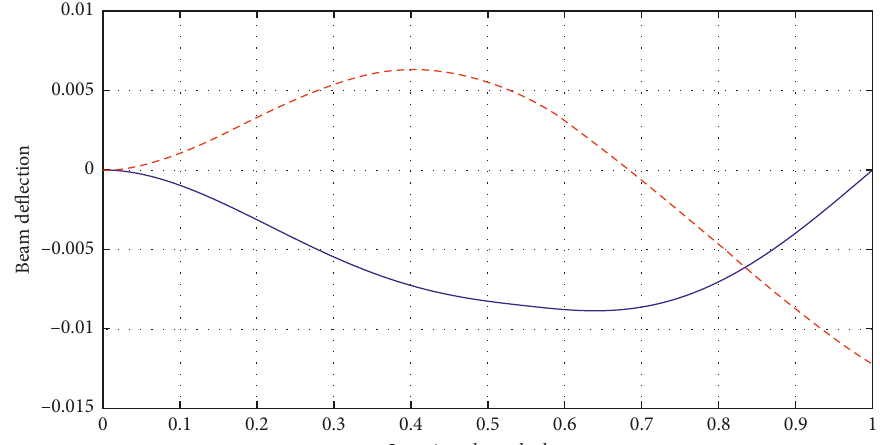
Figure 2: The steady state deformed shape of a collocated controlled (solid line) and uncontrolled (dashed line) damped cantilever beam when c 1 � 0.1, c 2 � 0.001, ω � 30, x f � 1, x n � 1, and x a � 0.55.